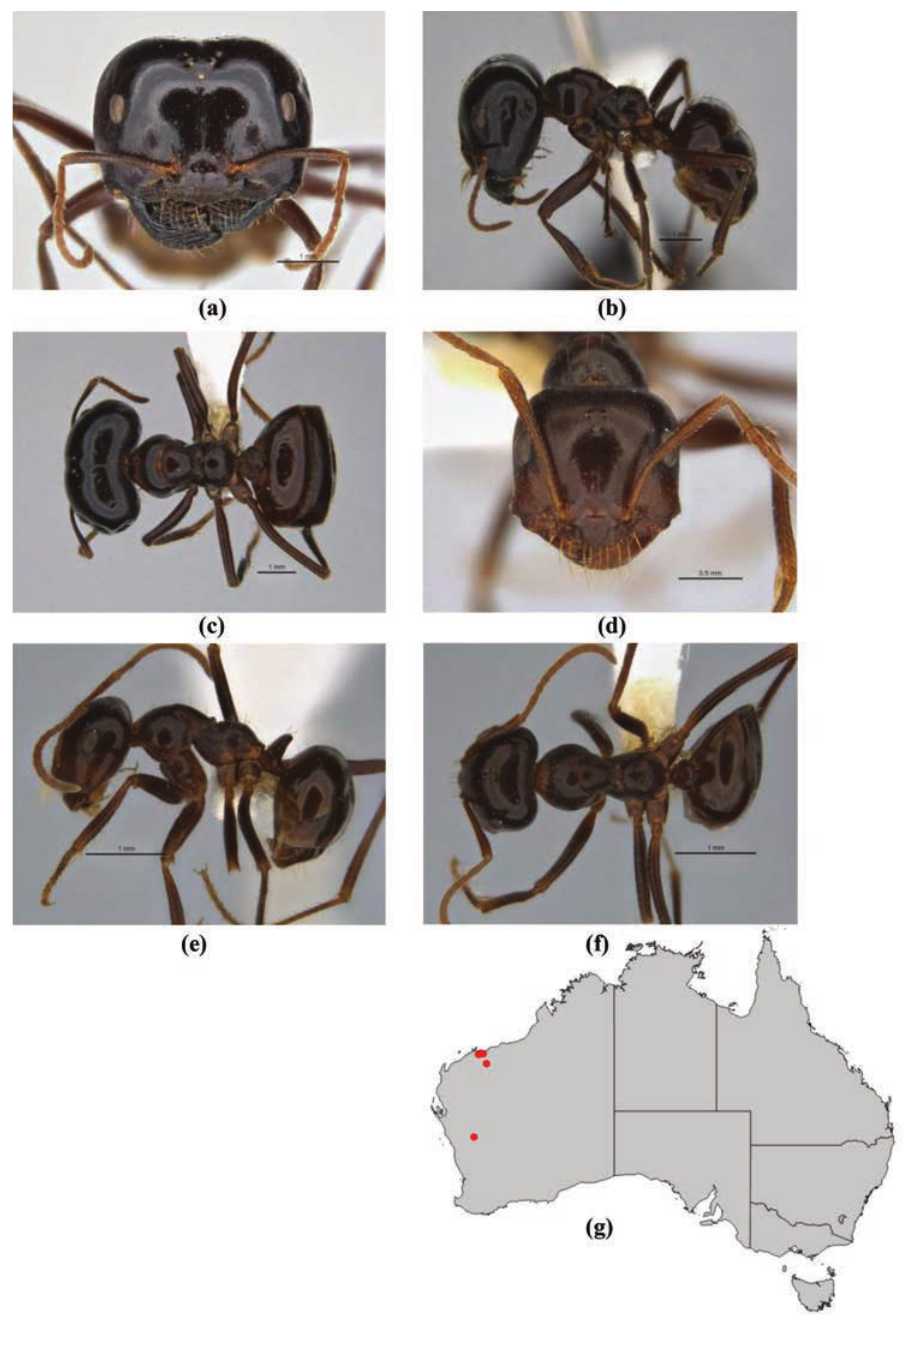
Figure 85. Melophorus prominens sp. n.: major worker paratype (ANIC32-900142–top ant) frons ( a ), pro- file ( b ) and dorsum ( c ); minor worker holotype (ANIC32-900142–bottom ant) frons ( d ), profile ( e ) and dorsum ( f ); distribution map for the species ( g ). Low resolution scale bars: 1 mm ( a–c, e, f ); 0.5 mm ( d